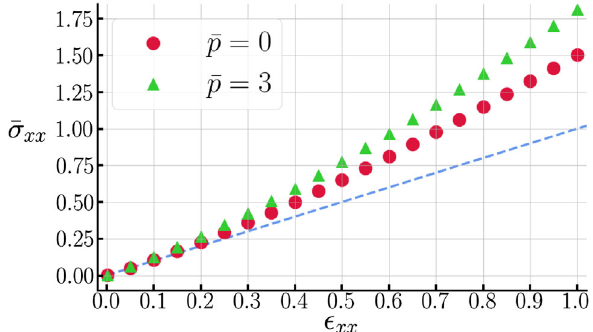
FIG. 16. Stress-strain curve of the MSM model. ¯ p represents the dimensionless volumetric pressure. Including the volumetric pressure increases the